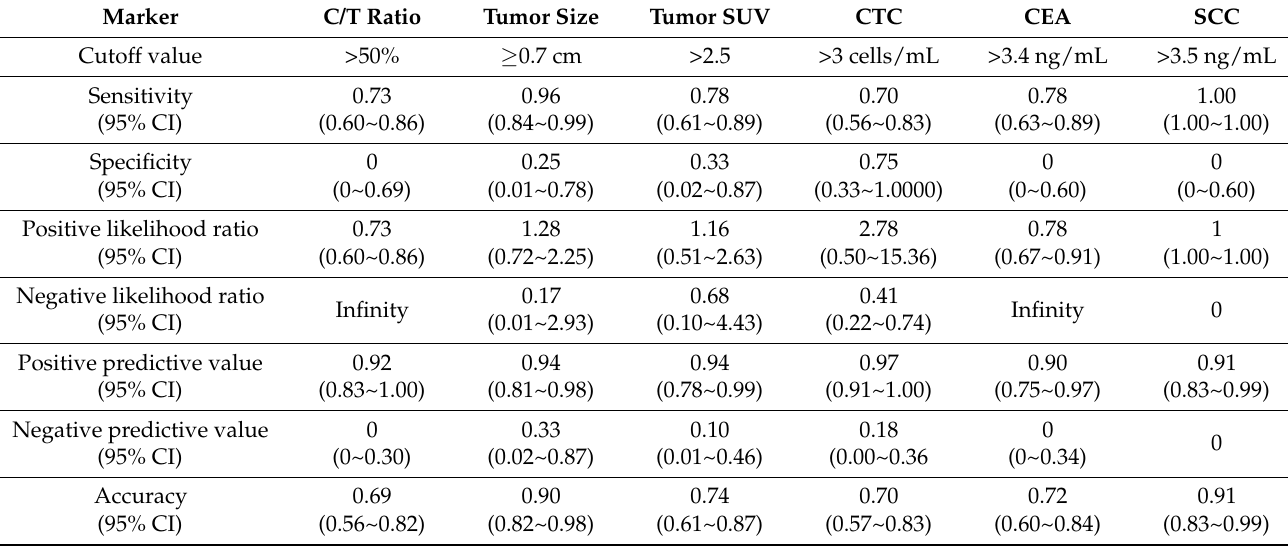
Table 3. Positive predictive and negative predictive rate among different tumor markers based on cutoff values clarified in the